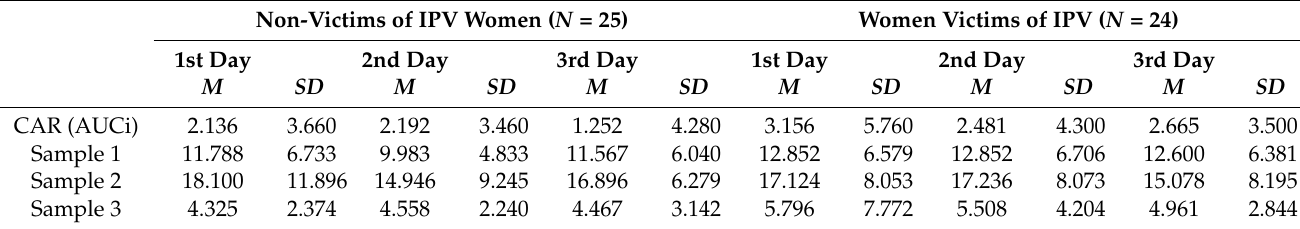
Table 2. Statistical descriptive summary of the different cortisol concentrations obtained in the samples collected from the two sample populations under study. Data expressed nmol/l.